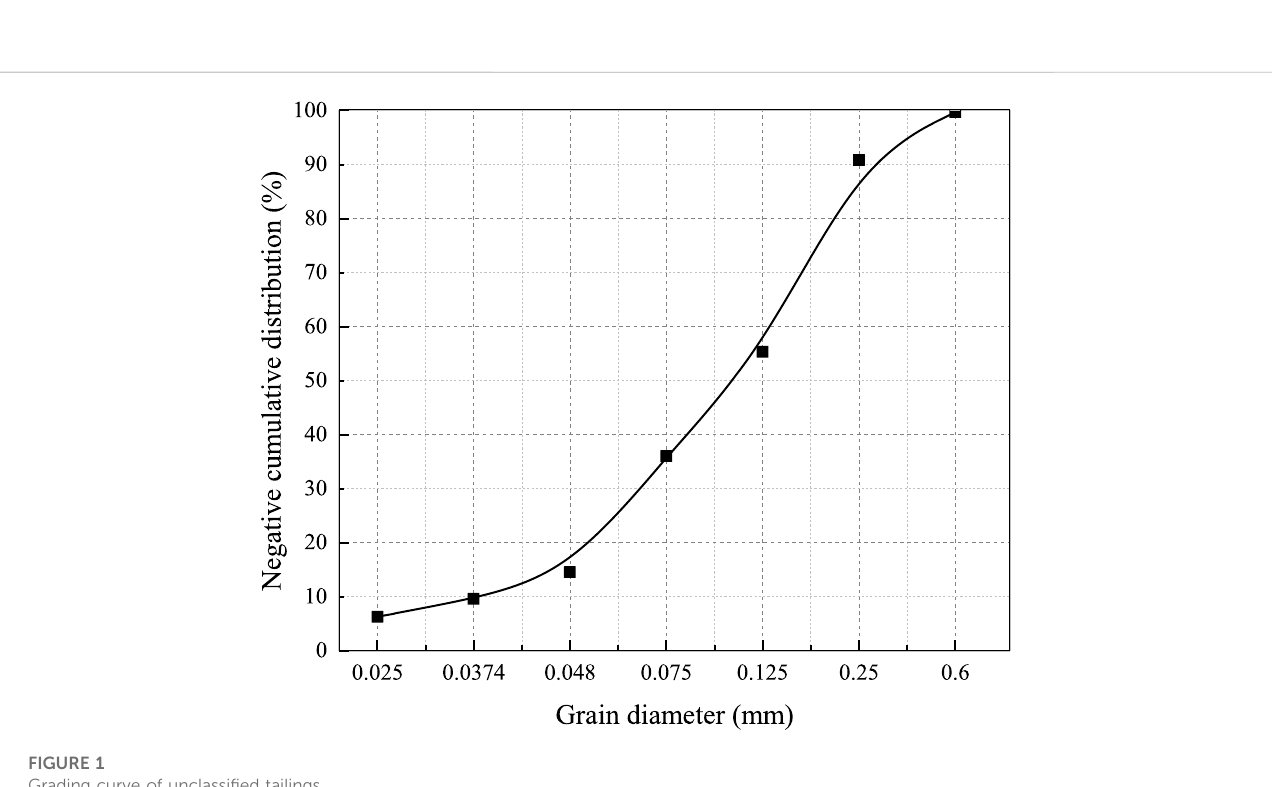
FIGURE 1 Grading curve of unclassi fi ed